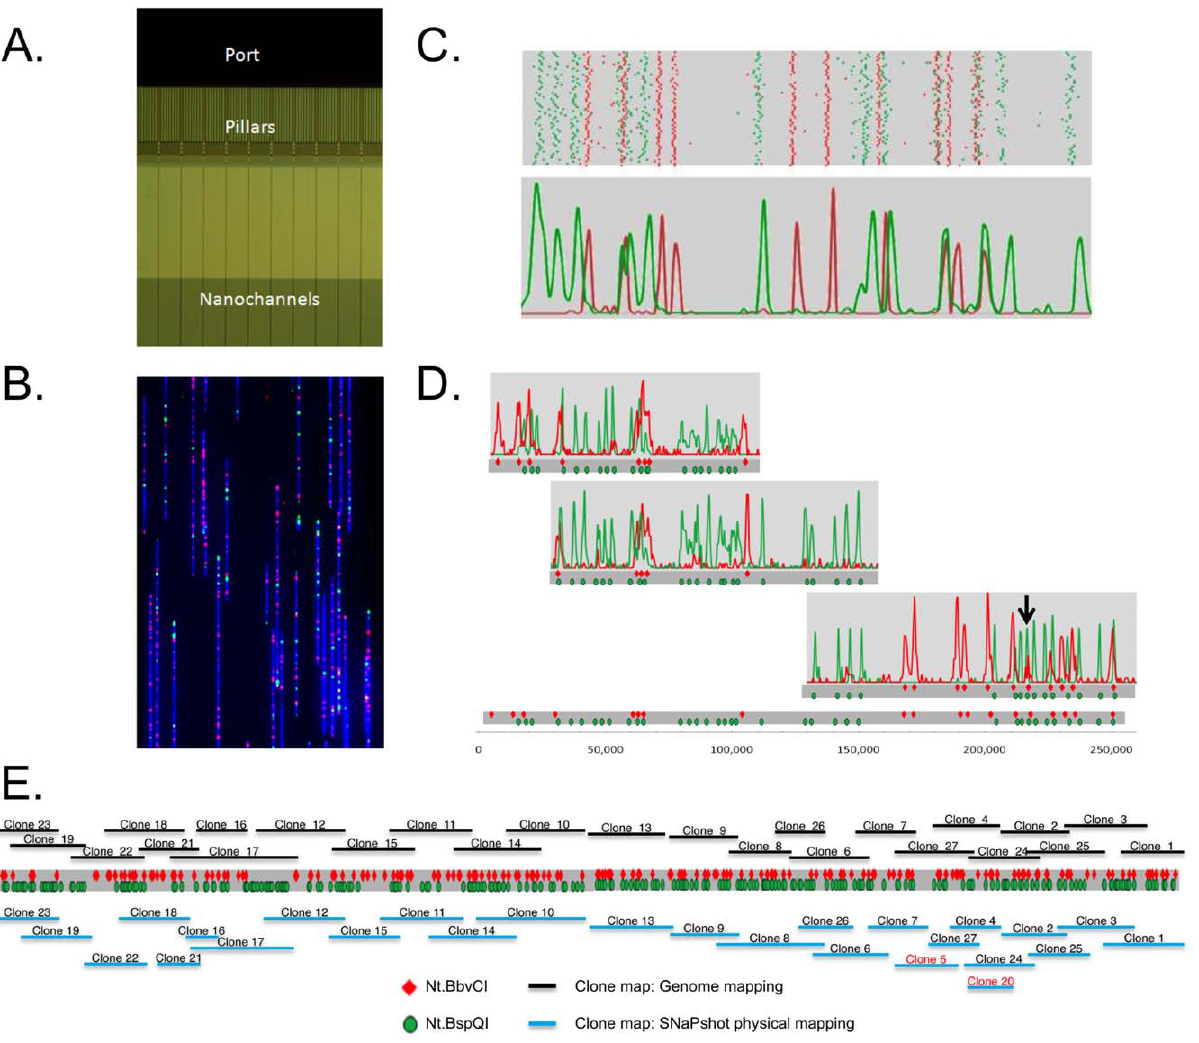
Figure 1. Two-color genome mapping with two enzymes. A. The DNA backbone is stained with YOYO-1 and loaded into the port of a nanochannel array chip. The DNA molecules are introduced into the region with pillars and micron-scale relaxation channels by an electric field where they unwind and linearize. Finally, they are moved into the 45 nm nanochannels, where they stretch uniformly to 85% of the length of perfectly linear B-DNA. B. Linearized BAC DNA molecules in nanochannels. The DNA molecule is stained with YOYO-1, and Nt.BspQI and Nt.BbvCI nicks are labeled with green and red dyes, respectively. C. Molecule length and nick locations are extracted from the images by custom image-analysis software. By clustering individual molecules with high similarity of green label patterns, distinct patterns are extracted (top panel). The locations of the red labels are then overlaid on the green label patterns (middle pattern). A histogram plot of the above clusters is shown in the bottom panel. The peaks represent the location of each sequence motif (GCTCTTC and CCTCAGC) along the linearized DNA molecules. D. Consensus maps for individual BAC clones are shown. Consensus maps are combined by using overlapping patterns, and the final genome map is shown at the bottom. E. The clone map from genome mapping is shown at the top and the full genome map as a grey bar with Nt.BspQI and Nt.BbvCI motif locations in green and red. Below the genome map, in blue, is the physical map from SNaPshot fingerprinting. The total length of the genome map is 2.1 Mb.